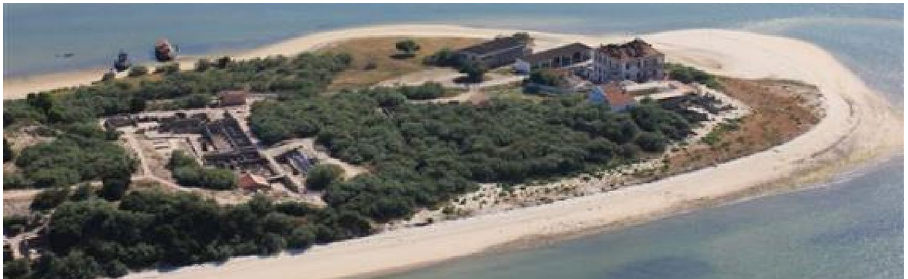
Fig. 1 The northwestern area of the Roman ruins on the right bank of the Peninsula of Tróia, Source Tróia Resort. Reprinted with permission